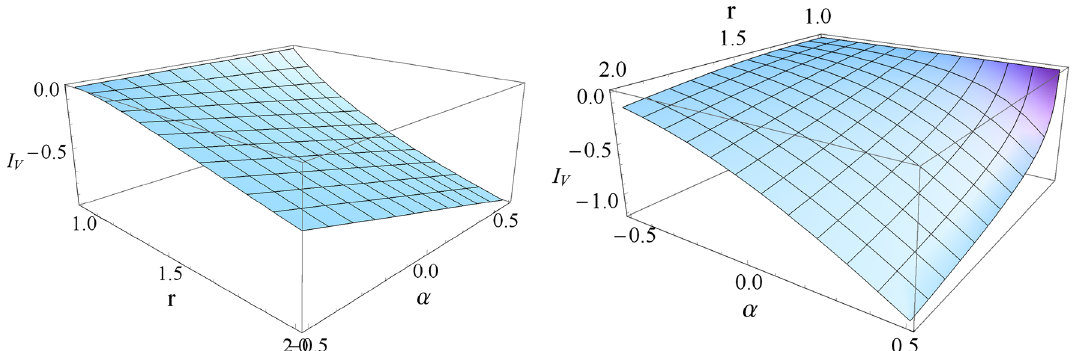
then I V → 0, i.e. 0